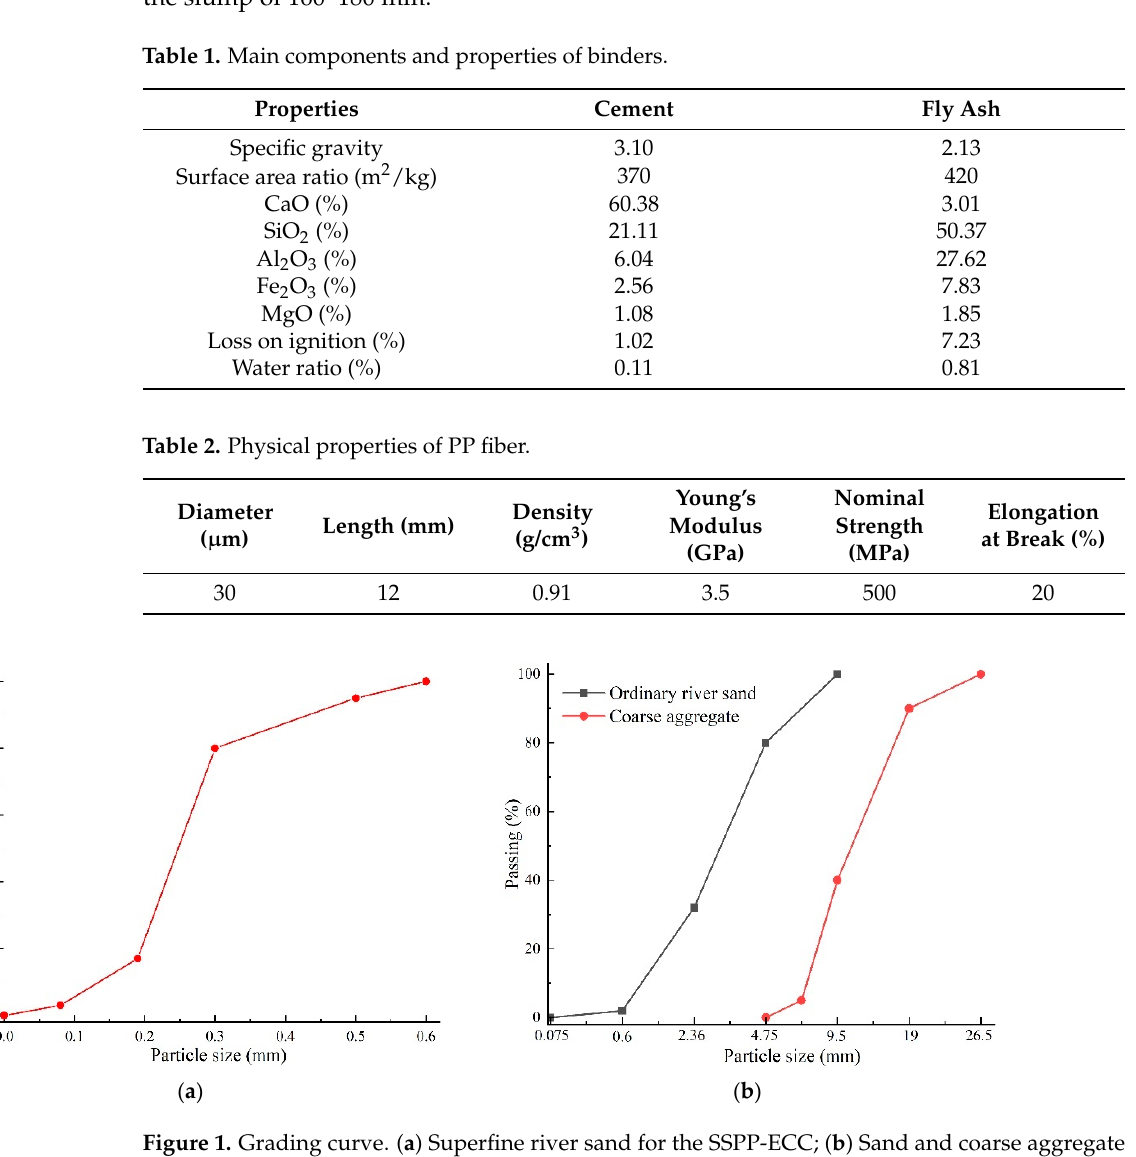
Figure 1. Grading curve. ( a ) Superfine river sand for the SSPP-ECC; ( b ) Sand and coarse aggregate for ordinary concrete. Table 2. Physical properties of PP fiber.